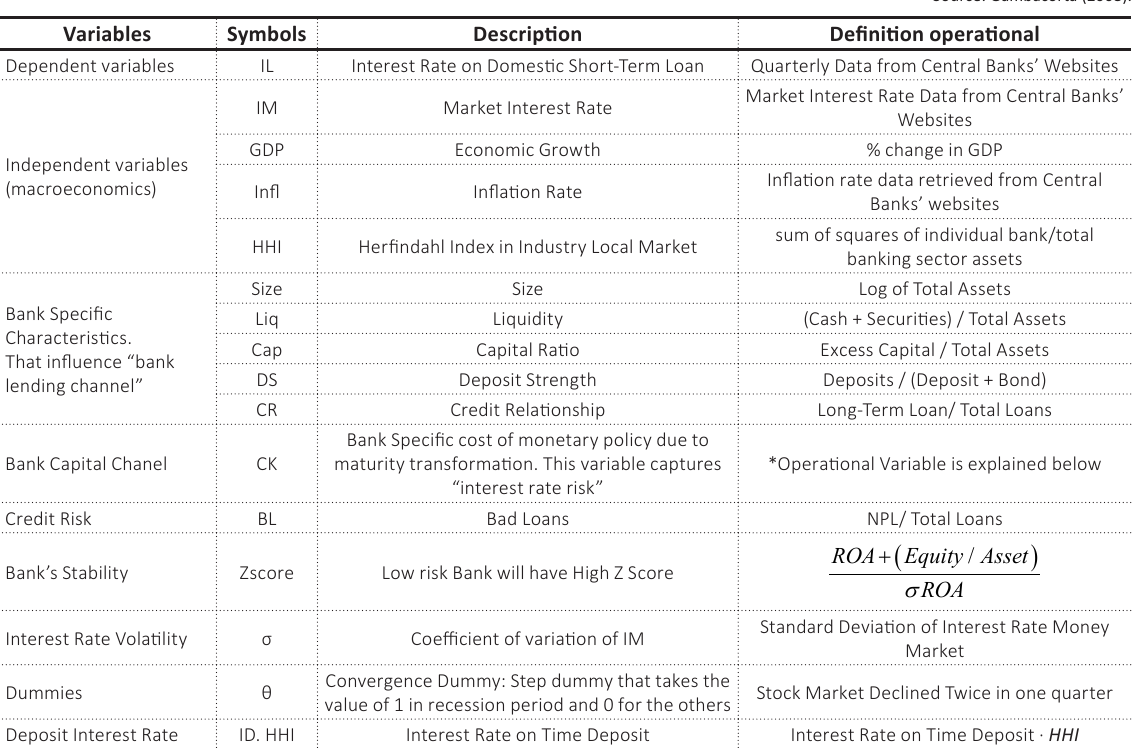
Source: Gambacorta